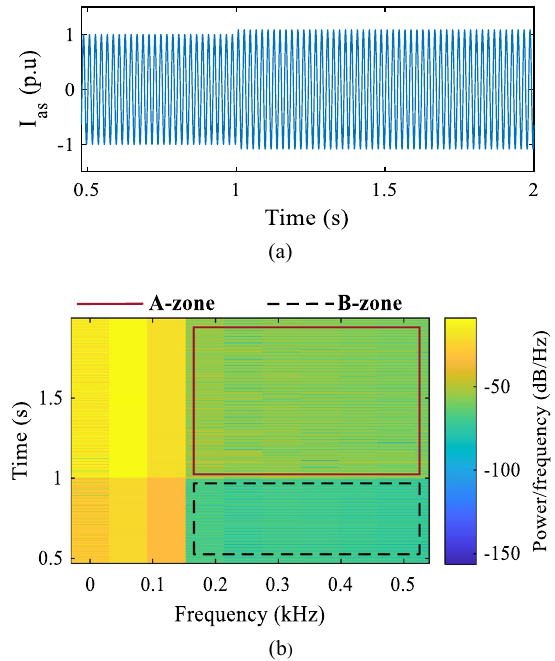
Fig. 2 A simulated inter-turn fault ( µ = 0.05 ) characteristics, a The a-phase stator current signal, b a-phase stator current spectrogram